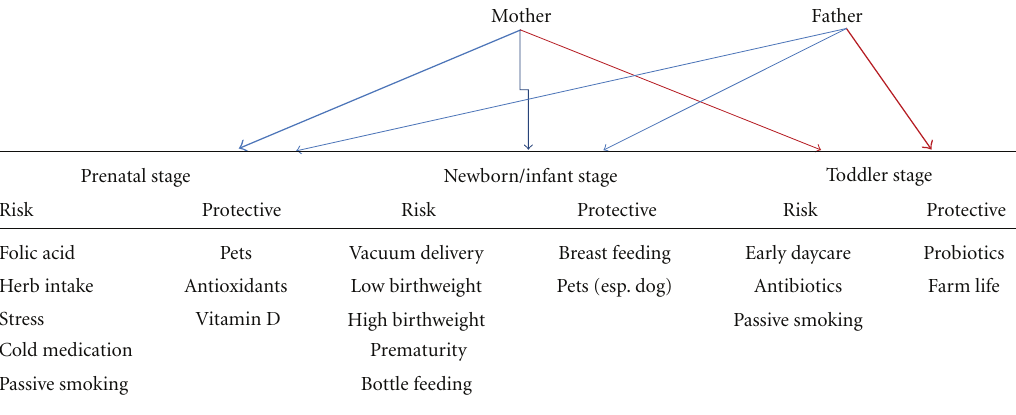
Figure 1: Summary of environmental (epigenetic) and genetic programming of